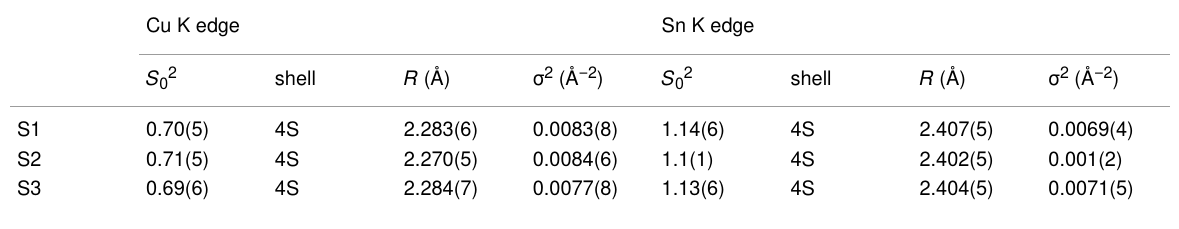
Table 4: EXAFS multiparameter fits for the studied